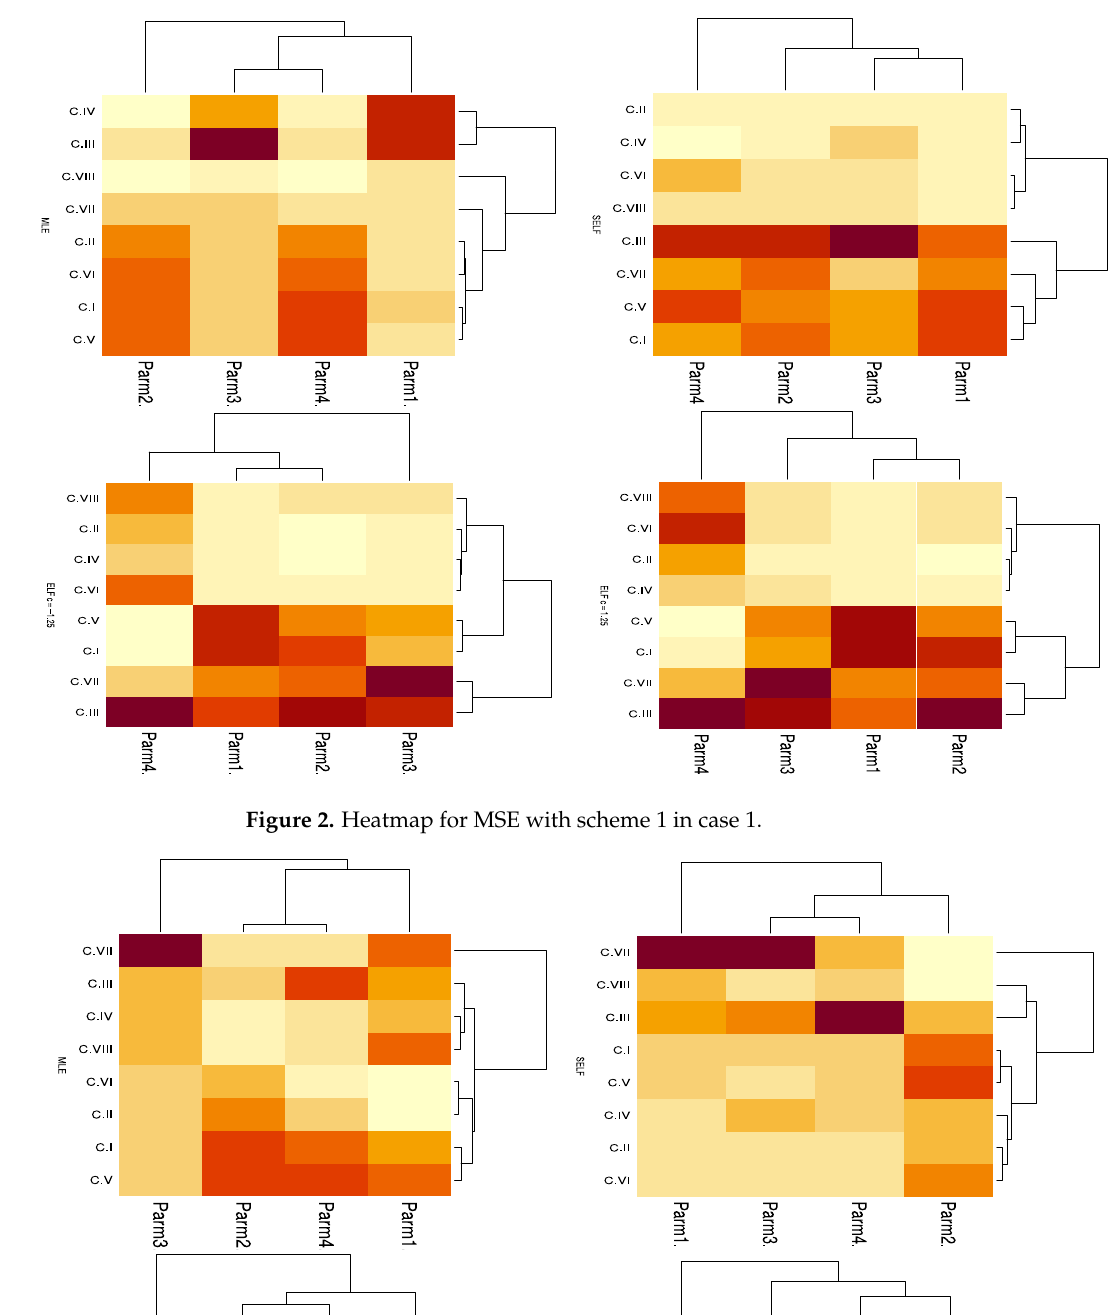
Figure 3. Heatmap for MSE with scheme 1 in case